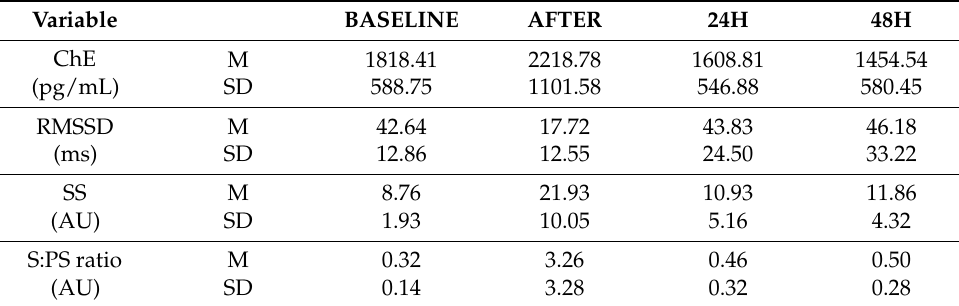
Table 2. Descriptive analysis of the analyzed